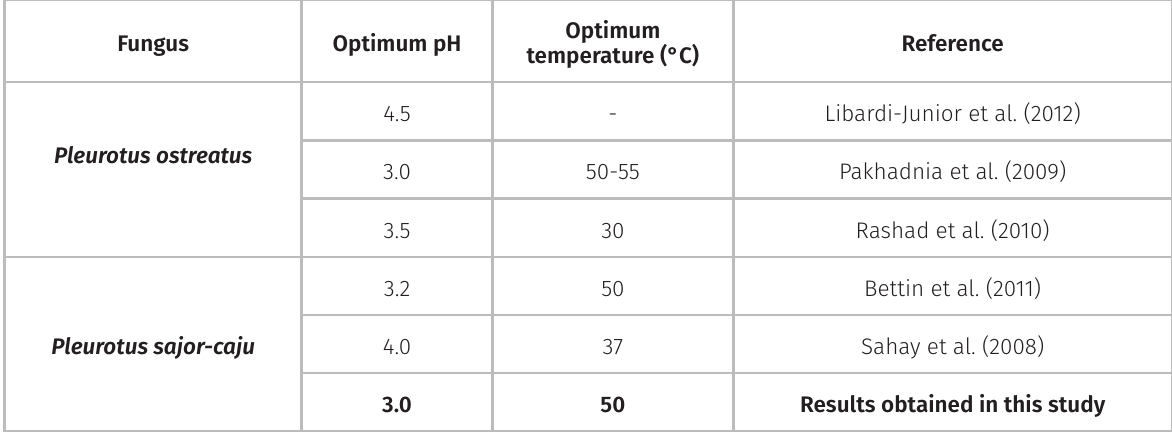
Table III. Optimum pH and temperature values of the laccase isoforms originating from different Pleurotus